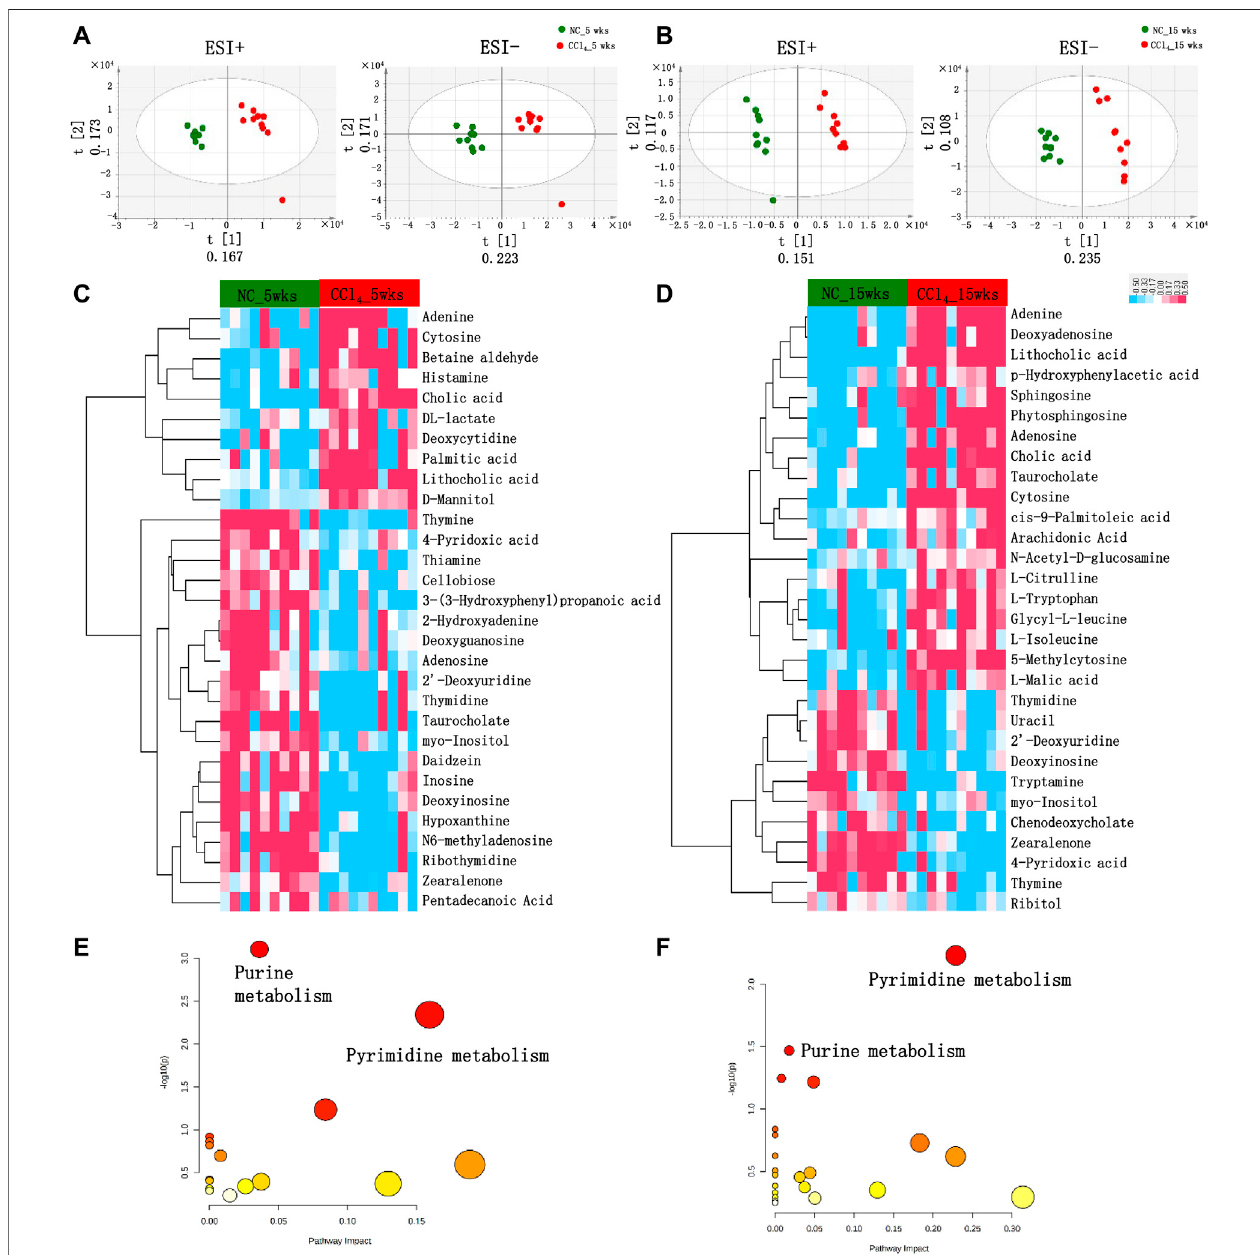
FIGURE 3 | Differential fecal metabolomics pro fi ling in mice during the development of CCl 4 -induced liver cirrhosis. (A, B) PLS-DA score plots based on the fecal metabolomicspro fi lesinbothESI+andESI − modelsusingUPLC-MS/MSdataafter5or15-weeksintervention. (C,D)